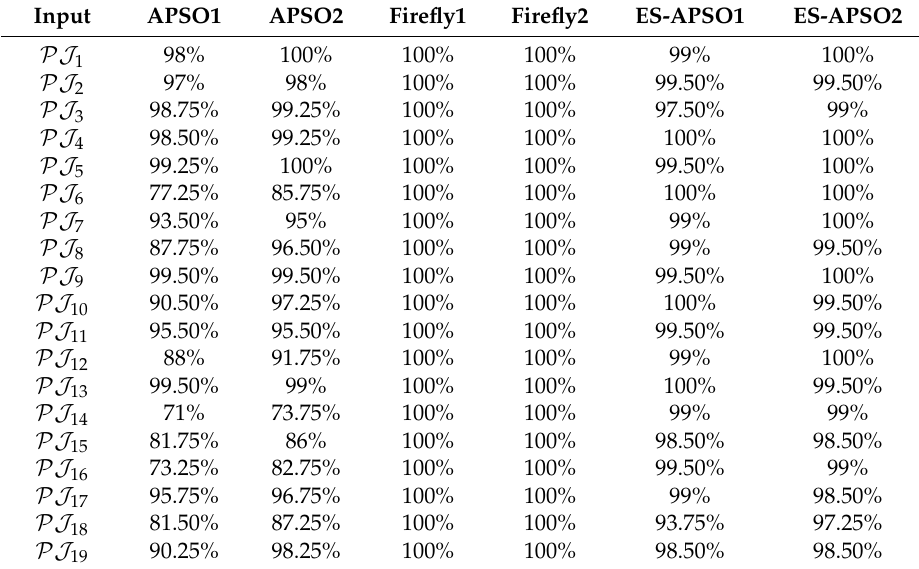
Table 1. The SR values of the proposed algorithms.